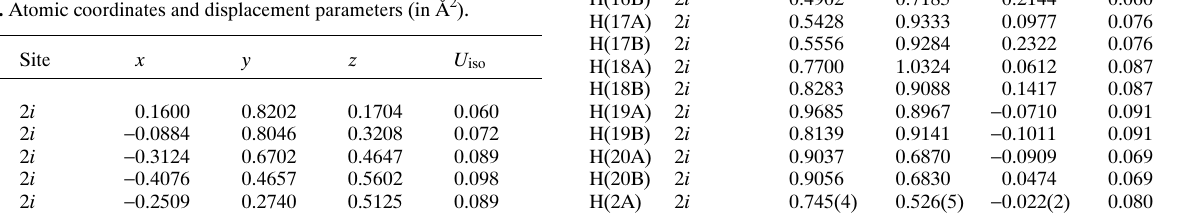
Table 2. Atomic coordinates and displacement parameters (in Å 2 ) .